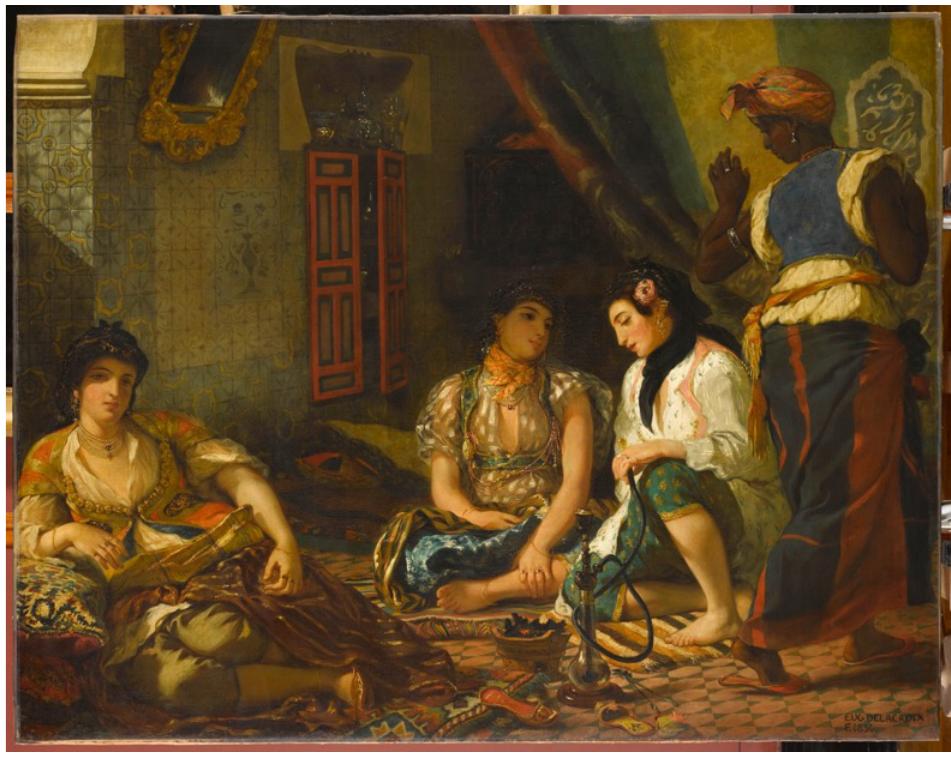
Figure 2 Eugène Delacroix, Femmes d’Alger dans leur appartement , 1834. Oil on canvas. 180 x 229 centimeters. Musée de Louvre, Paris, France. (photo: Franck Raux).  RMN- Grand Palais / Art Resource,